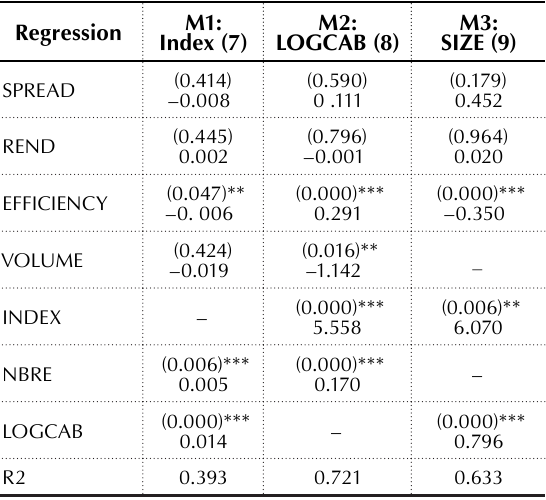
Table 3 (cont.). Variable seemingly unrelated regression (three columns of MCO